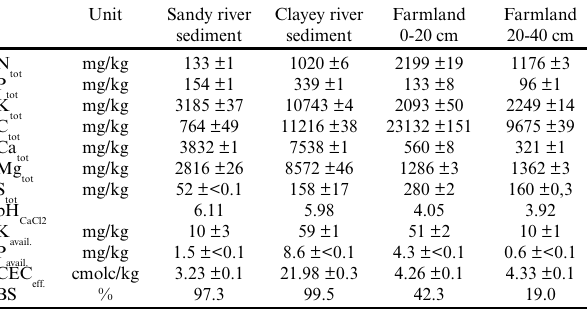
Table 4 . Total nutrient concentrations, pH, plant available K and P, effective cation exchange capacity (CEC ), and base saturation eff (BS) of the farmland and the river sediments. Number of analyzed samples was n = 2, with the exception of pH and BS (n =